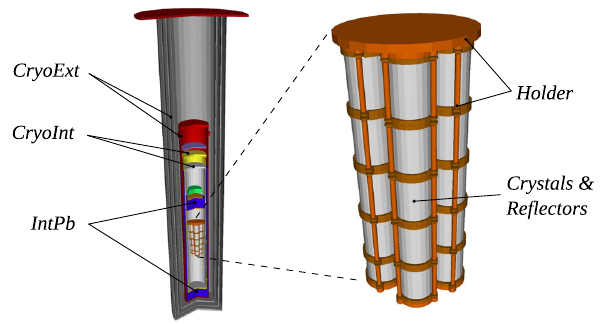
Fig. 3 Graphic view of the CUPID-0 experimental setup as modeled in Geant4 with the Arby toolkit. External lead and neutron shield are included in the MC but not represented